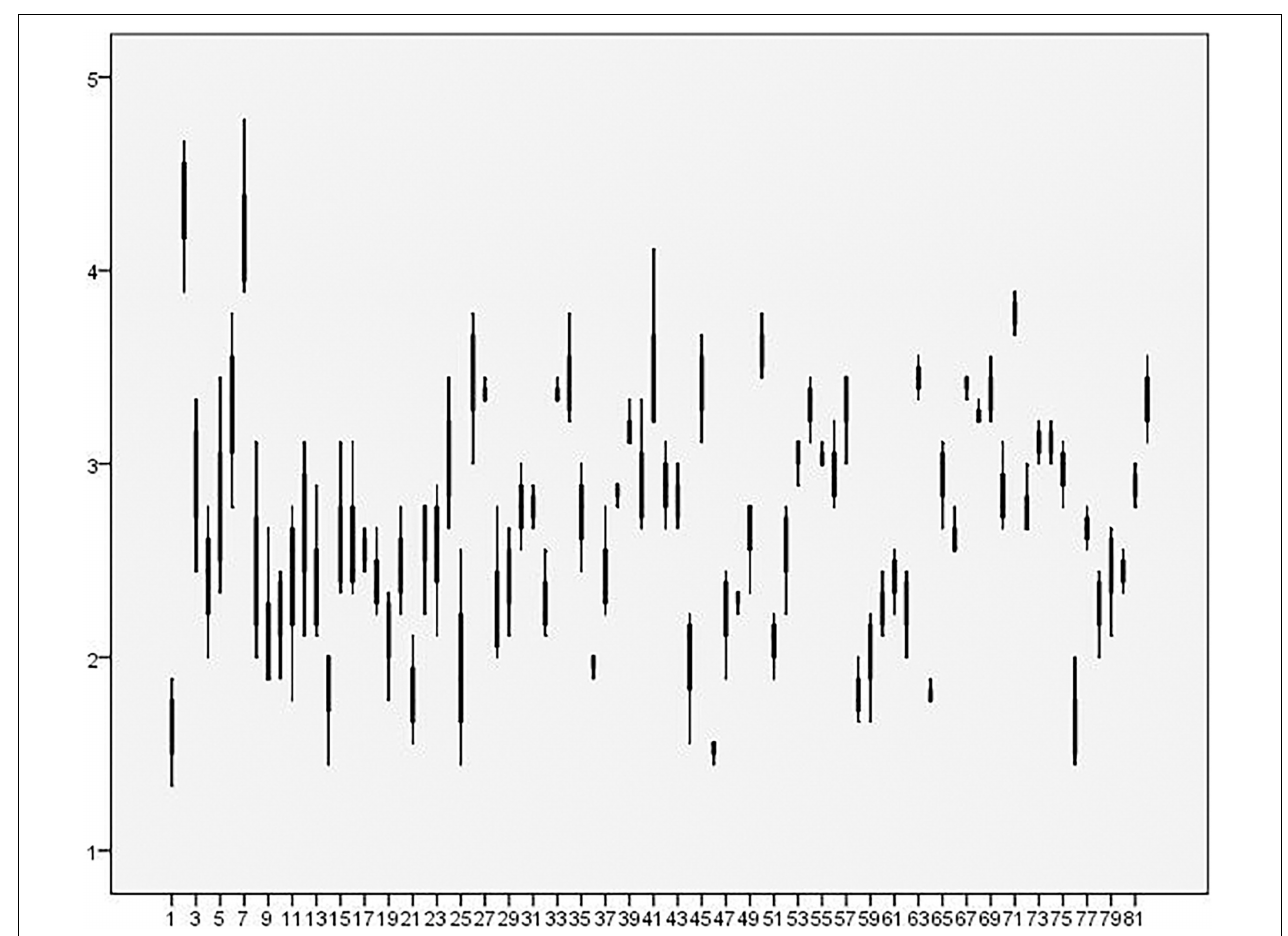
FIGURE 2 | The box-and-whisker plot of member creative deviance for 82 independent R&D teams (Sorting by the team